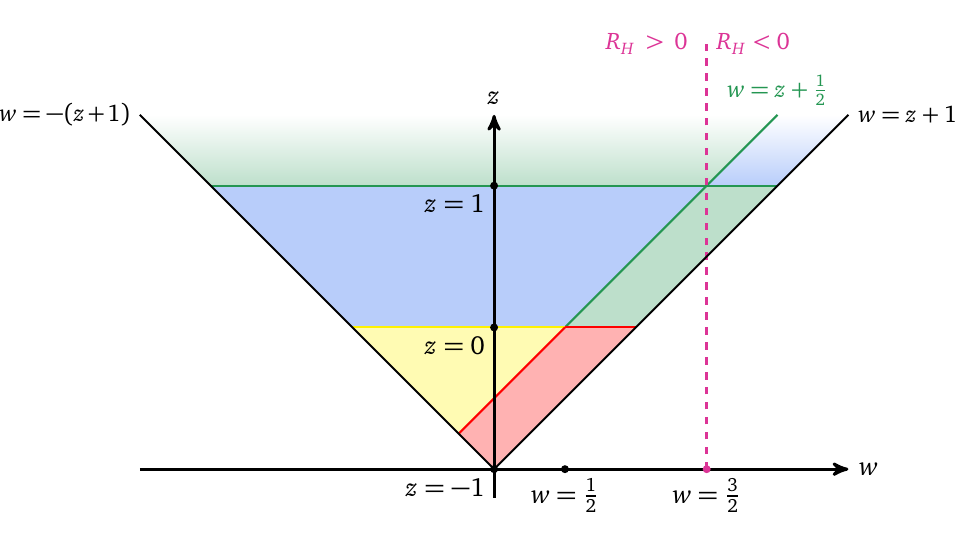
Figure 3: Four domains in ( w , z ) -parameter space with different qualitative Ricci